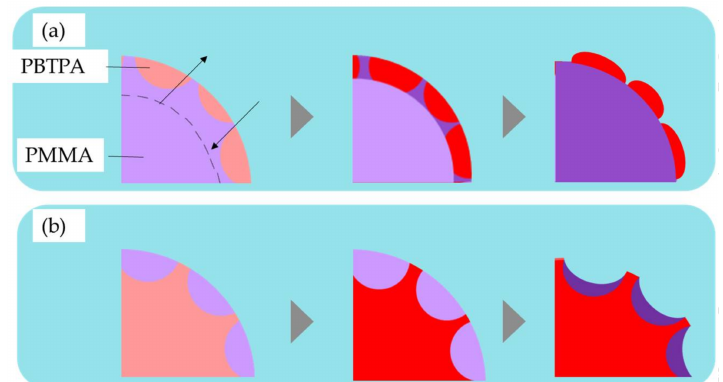
Figure 5. Formation of surface morphology of microspheres of PBTPA/PMMA blend (the surface consists mainly of ( a ) PMMA-rich phase, ( b ) PBTPA-rich phase).